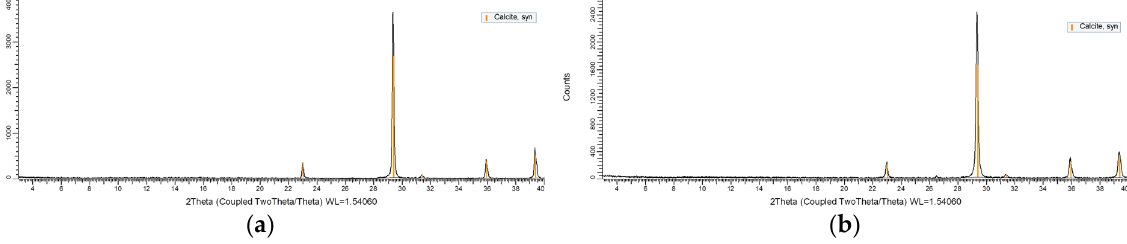
Figure 1. XRD analysis of the mineralogical composition of core material for Bashkirian ( a ) and Vereian ( b ) production zones.